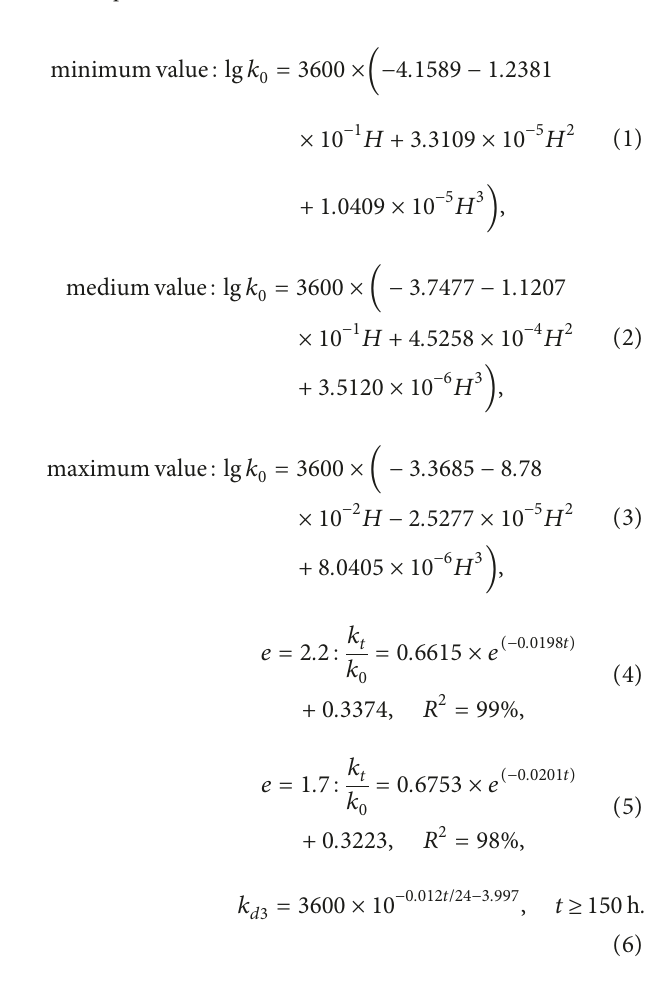
Figure 4: Saturated permeability distribution of drainage layer in the temporal domain